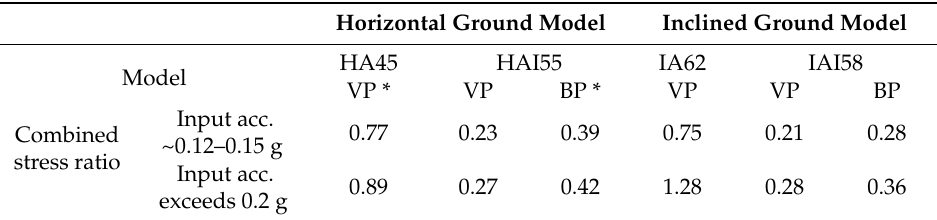
Table 6. Calculation of the combined stress ratio for each